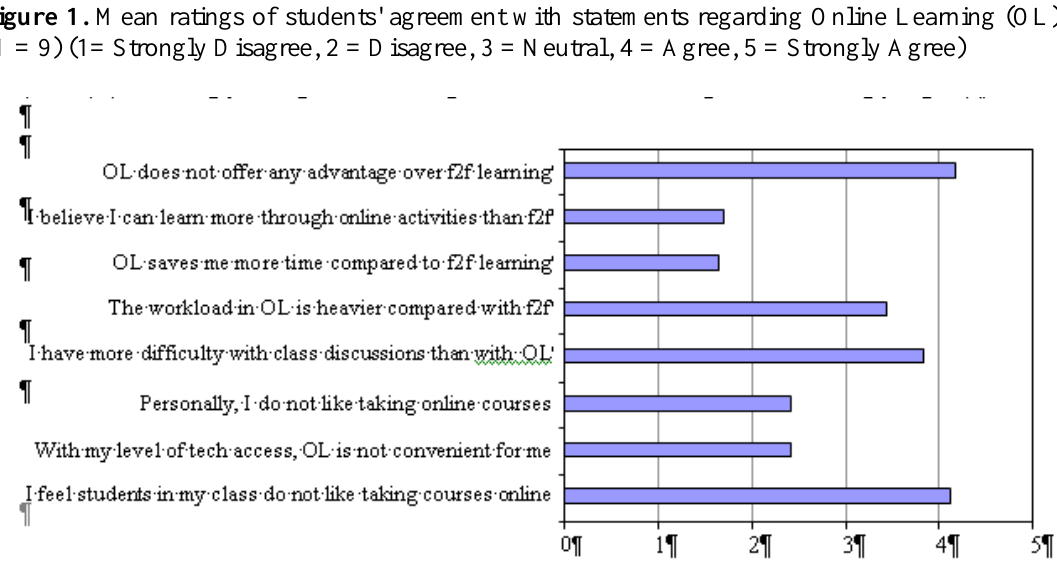
These mixed results were confirmed by content analysis of the text of students' responses to open- ended questions and email enquiries. Two categories were identified: (a) time; and (b) lack of motivation for independent